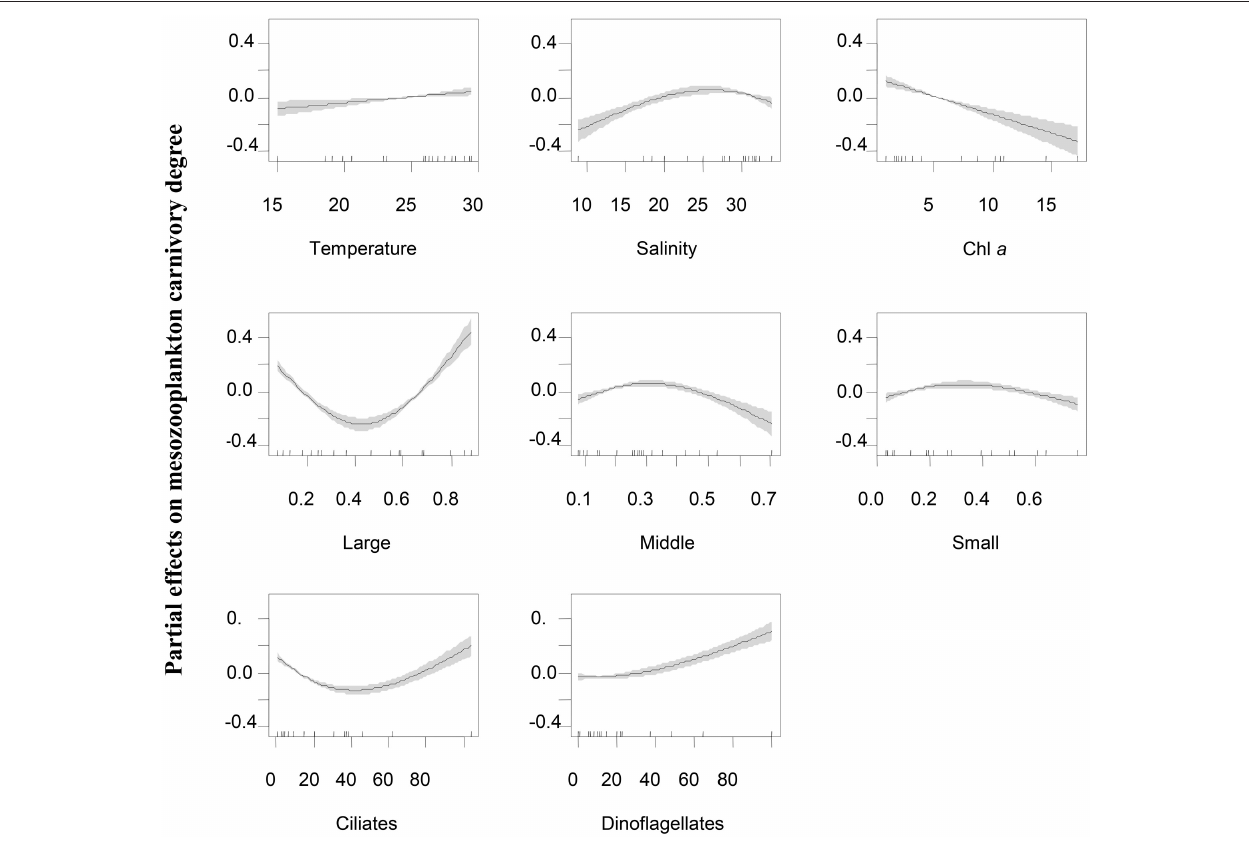
FIGURE 6 | Partial effects of variable predictors on mesozooplankton carnivory rate at station WE. Predictors includes temperature, salinity, Chl a concentrations, percentages of large-sized (Large), middle-sized (Middle) and small-sized phytoplankton (Small) in total phytoplankton community, ciliate biomass and dinoflagellate biomass. Shades indicate 95% of confidence